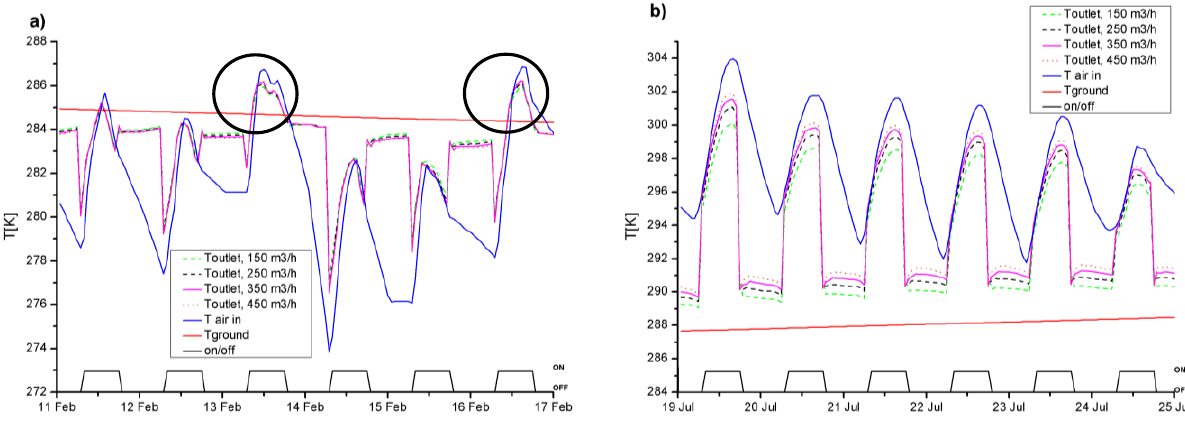
Figure 13. Ground and inlet-outlet air temperatures with λ = 2 W/m K, air-ground thermal power varying the air flow rate (range 150–450 m 3 per hour), for typical winter ( a , c ) and summer weeks ( b , d